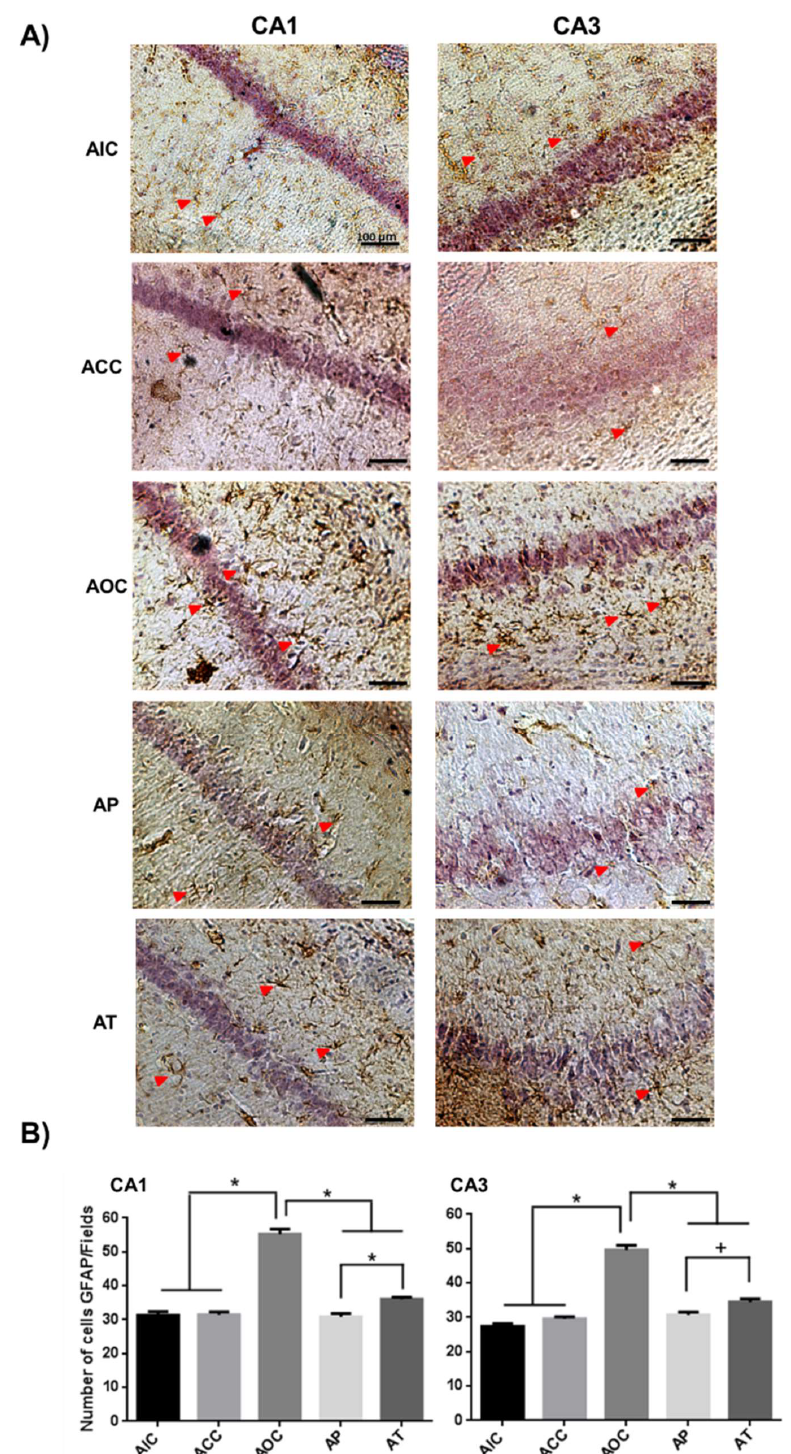
Figure 1. Effect of curcumin (CUR) on the astrocyte activation caused by acute exposure to O 3 . ( A ) Representative light photomicrographs show glial fibrillary acidic protein (GFAP) immunoreactivity (red arrowhead) in CA1 and CA3 regions of the rat hippocampus in the acute phase. The acute preventive (AP) and acute therapeutic (AT) groups showed decreased cell immunoreactivity. Scale bars 100 μm. ( B ) GFAP immunoreactive cells: The quantitation of GFAP positive cells from experimental groups was depicted in this graph as the mean ± SEM. * p < 0.001, + p < 0.01.